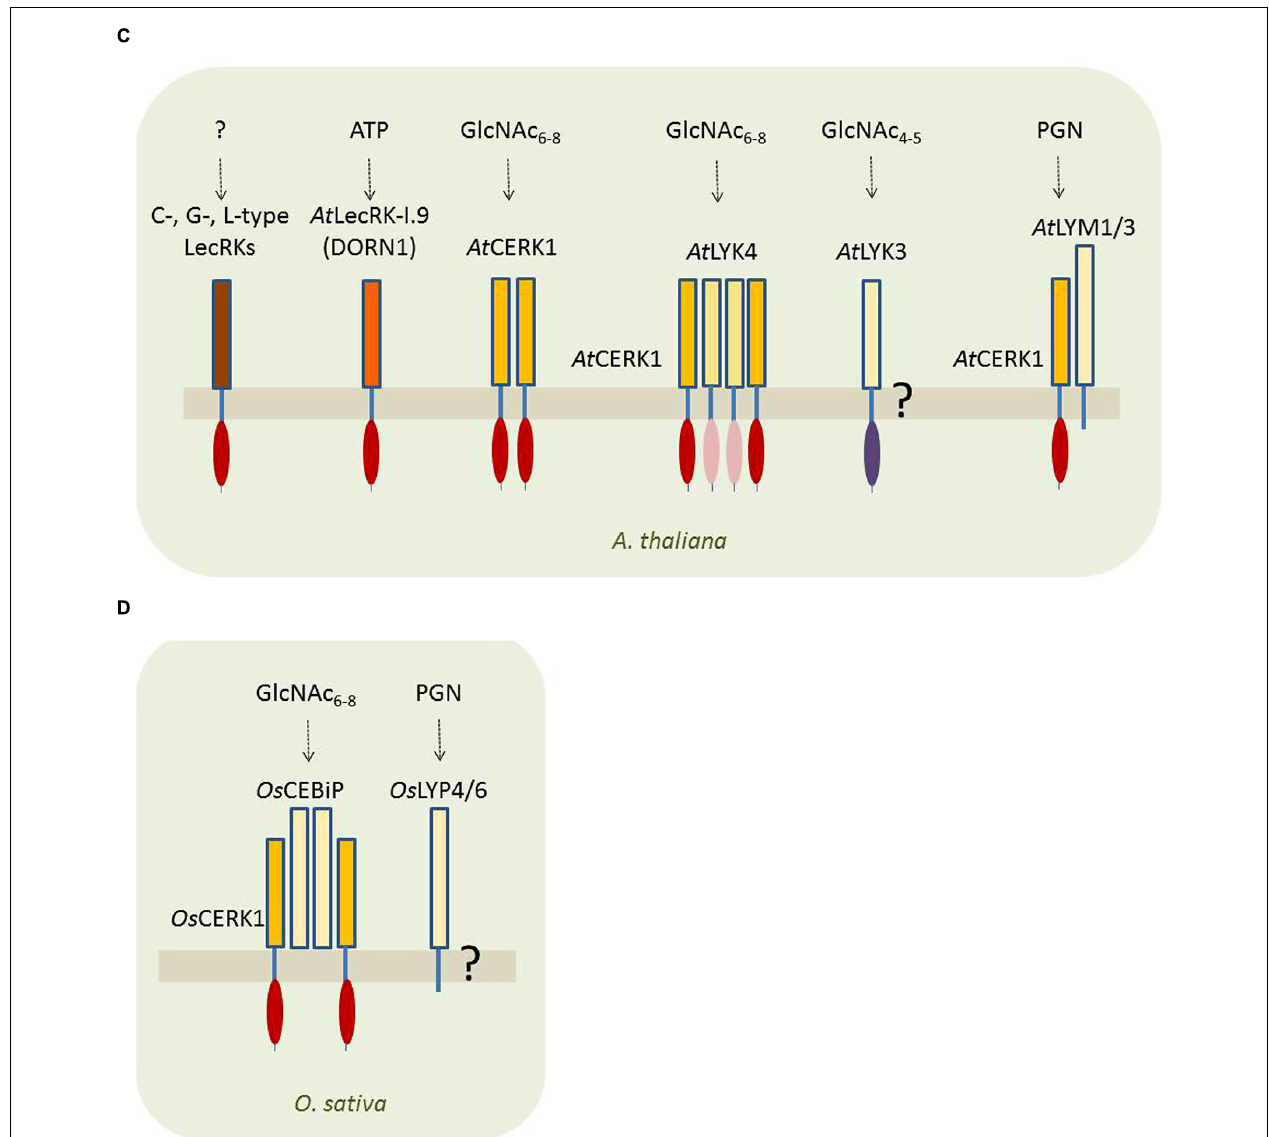
pink = non-functional, purple = putative kinase domain). (D) Transmembrane PRRs with lectin domains identified in Oryza sativa. The LysM domain recognizes P/M/DAMPs through specific binding of chitin fragments. Bars represent the LysM lectin domains; ellipses represent functional kinase